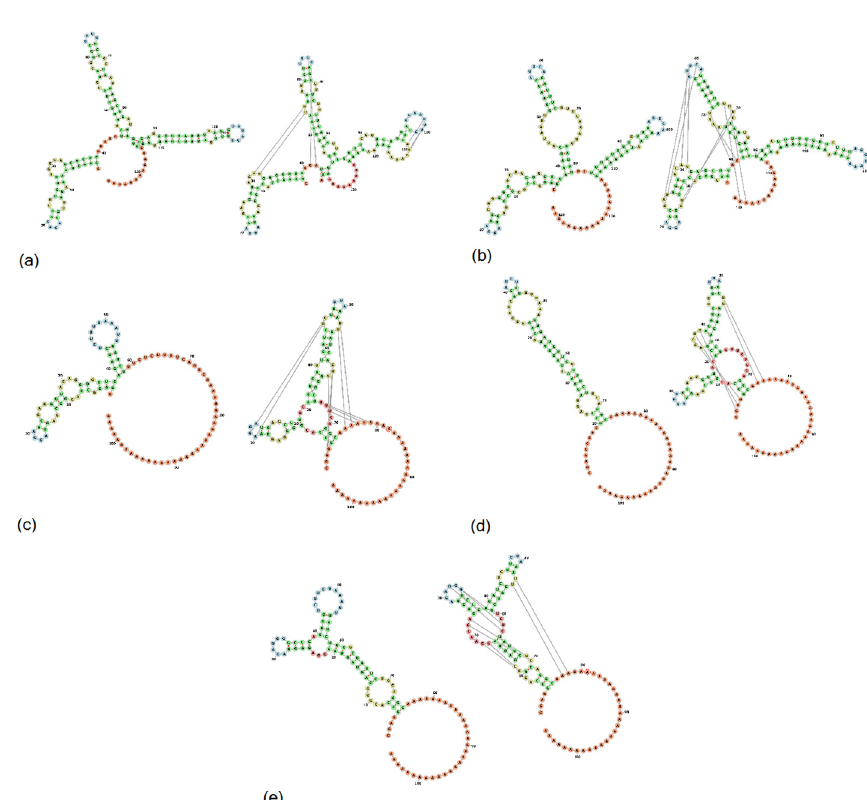
Figure 5. Secondary structure of the consensus PoAstV3 3‘UTR region of USA ( a ), Spanish ( b ), Hungarian ( c ) strains, strain GER/L00919-K17/2014 ( d ) and consensus Japanese strain ( e ). Secondary structures of ( a – e ) are illustrated without ( left ) and with pseudoknotted interaction ( right ). Green, yellow and blue bases indicate stems, interior loops, and hairpins, respectively. Red and orange bases indicate multiloops, and 5 ′ and 3 ′ unpaired regions, respectively.